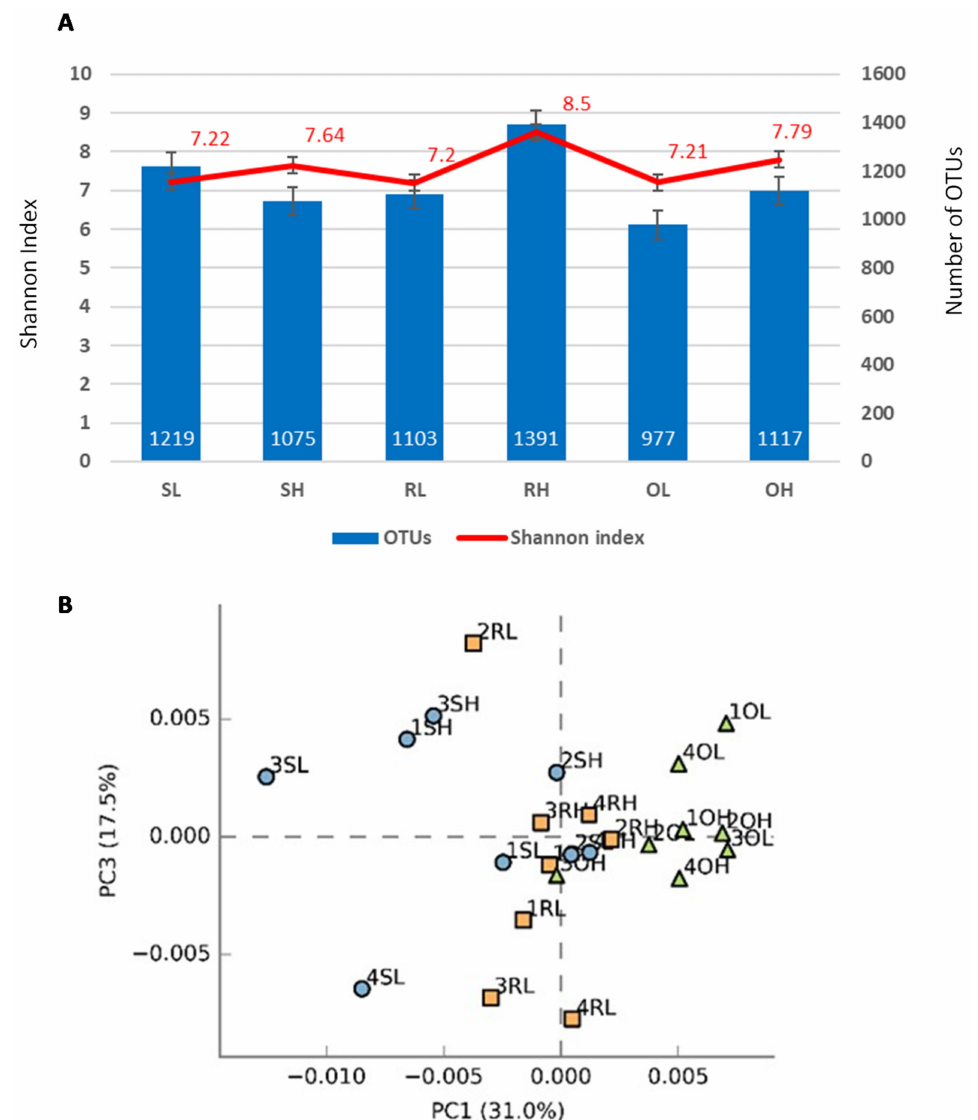
Figure 2. ( A ) Bacterial diversity in soils considering different rhizosphere samples (x-axis). ( B ) Principal component analysis (PCA) of bacterial communities in the different soil samples. S: sandy soils; R: red soils; O: red oxi-soils. H: high fire frequency; L: low fire frequency. Colors preceding the sample codes indicate one type of